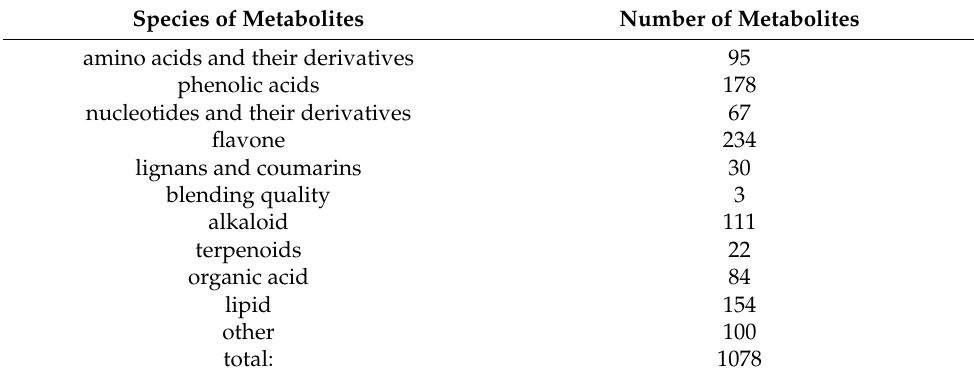
Table 1. Types and quantities of